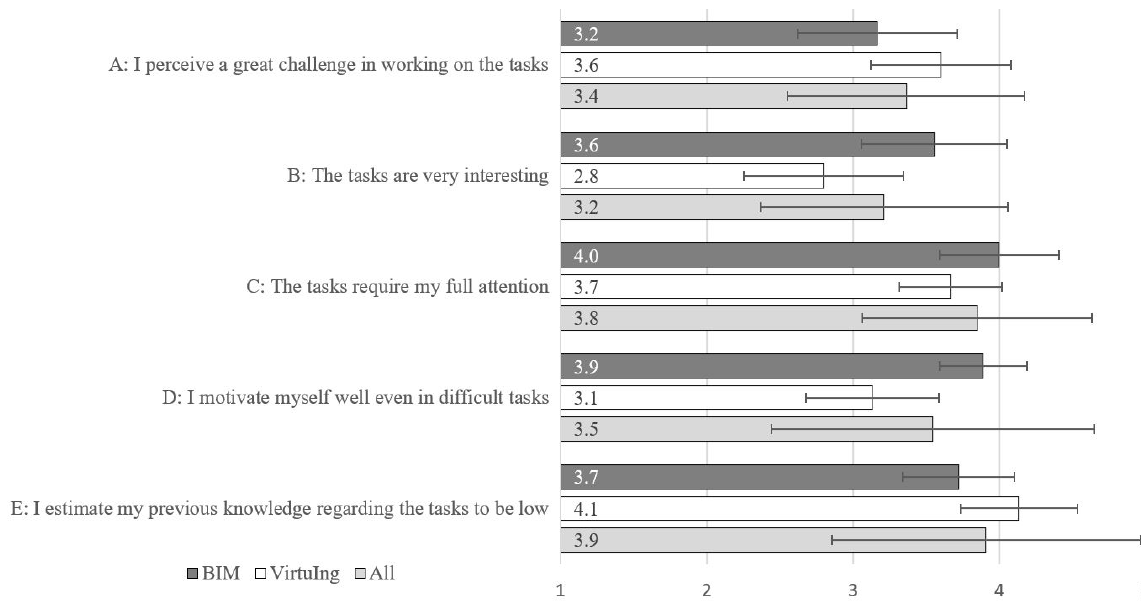
Table 3. Final Presentation.